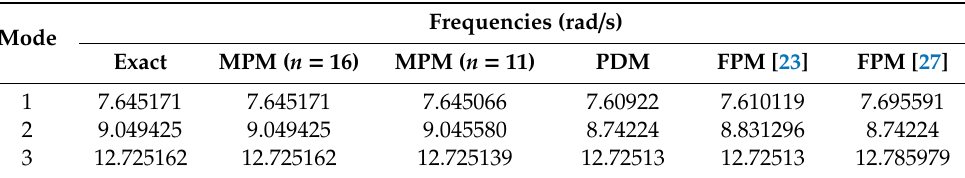
Table 4. The natural frequencies (rad / s) of the frame system.